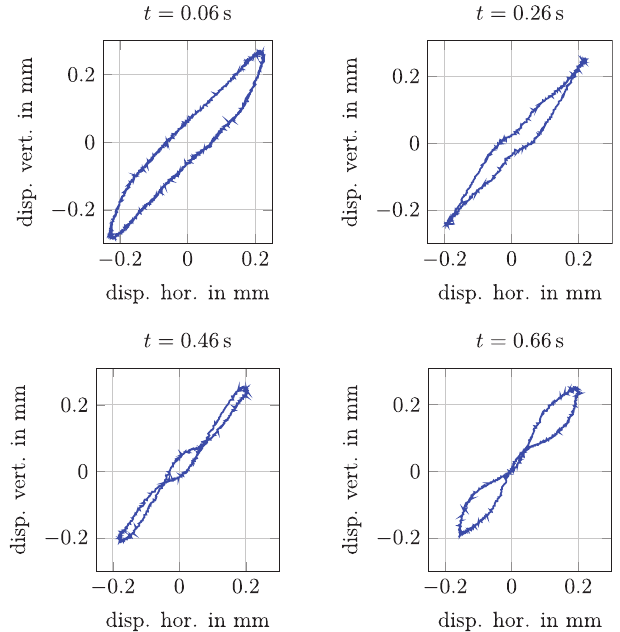
Figure 6. Transient development of the measured orbit diagram at four points in time close to the middle of the